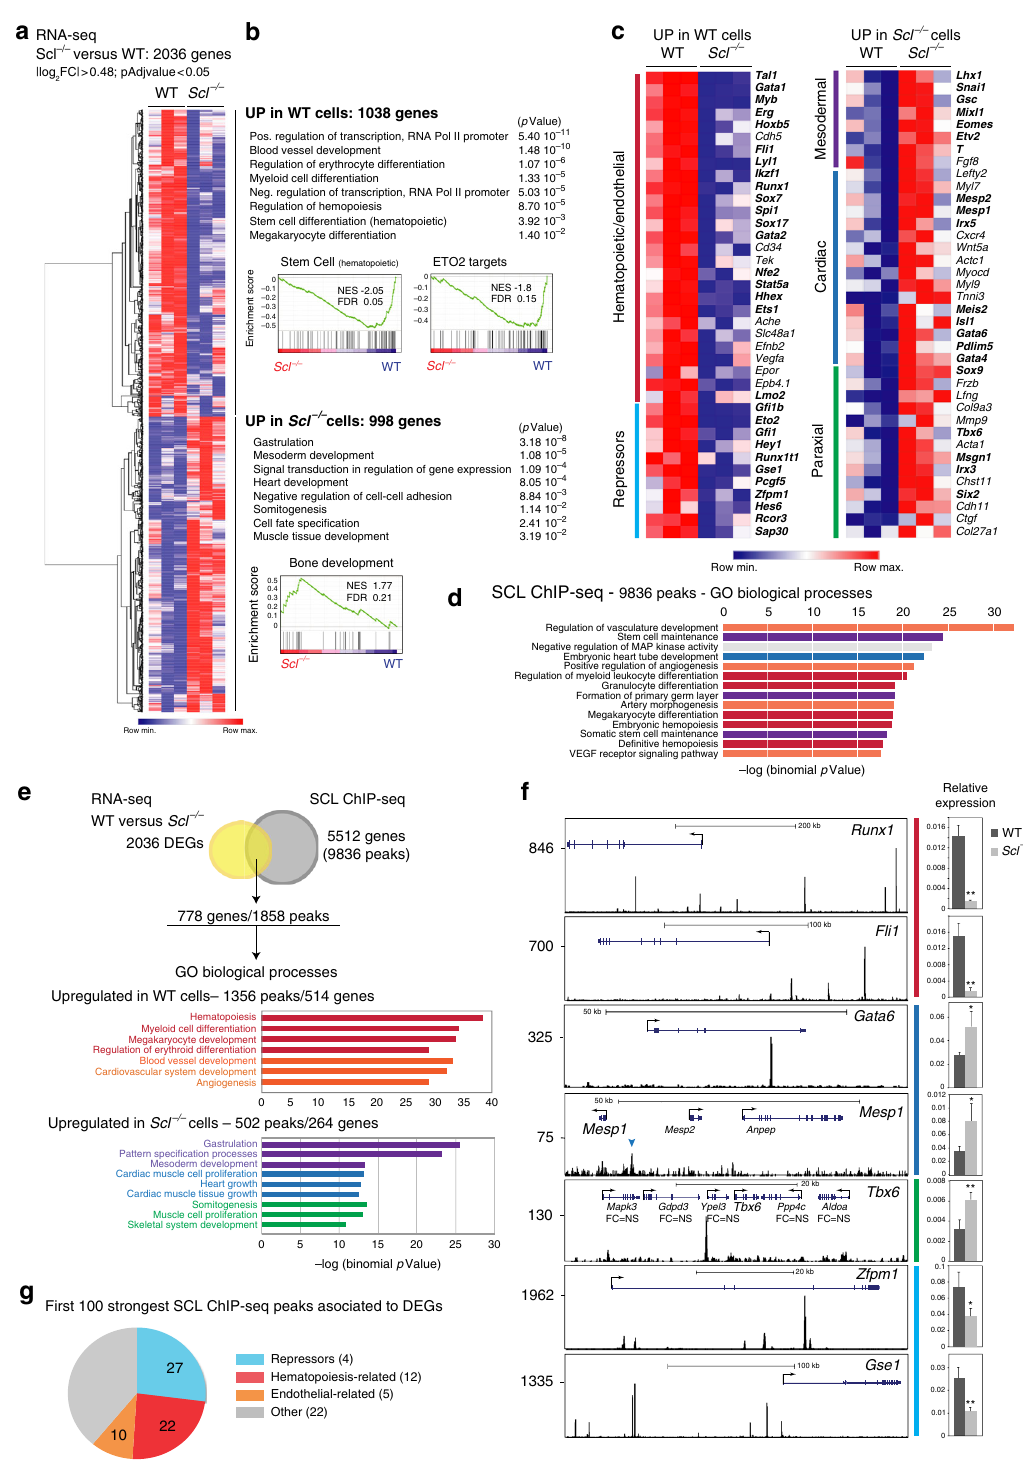
Fig. 4 SCL controls distinct gene regulatory networks in day 3.5 FLK1 + cells. a Hierarchical clustering of RNA-seq data from day 3.5 WT and Scl -/- FLK1 + EB cells. b Gene ontology (GO) processes associated to differentially expressed genes (DEGs) (PANTHER and GSEA analyses). c Heatmap showing selected DEGs associated to GO processes identi fi ed in b . In bold, transcriptional regulators. d The top more signi fi cant GO biological processes associated to SCL- bound loci (GREAT analysis). e Integration of SCL ChIP-seq and RNA-seq data reveals 778 SCL direct differentially expressed target genes. Below, GO terms attributed to DEG-associated peaks (GREAT analysis). f Left, SCL ChIP-seq tracks of selected direct DEGs; FC = NS, fold-change in expression in Scl -/- cells is not signi fi cant (RNA-seq data). Tbx6 locus: the SCL peak was attributed to Tbx6 , the closet DEG. Right, RT-qPCR gene expression analysis relative to Gapdh from WT and Scl -/- day 3.5 FLK1 + cells. n = 3, mean ± SD; student ’ s t -test, * p < 0.05, ** p < 0.01. Colour code, same as in c . g Biological functions attributed to the 100 strongest DEG-associated SCL ChIP-seq peaks. In brackets, numbers of genes in each category. See also Supplementary Data 1,